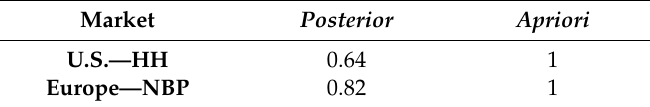
Table 11. “Posterior” and “apriori”